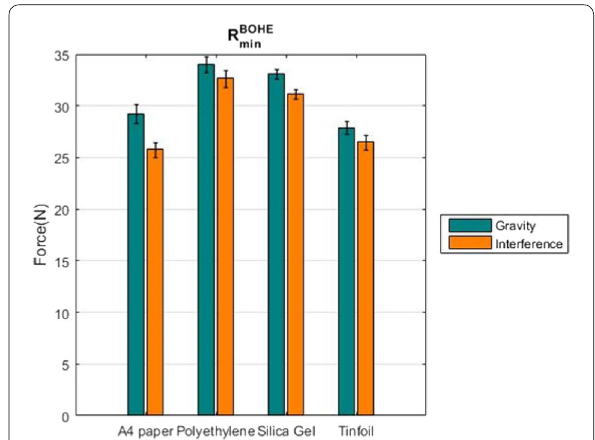
Figure 9 Grasping ability of BOHE grasping mode with the minimal object size